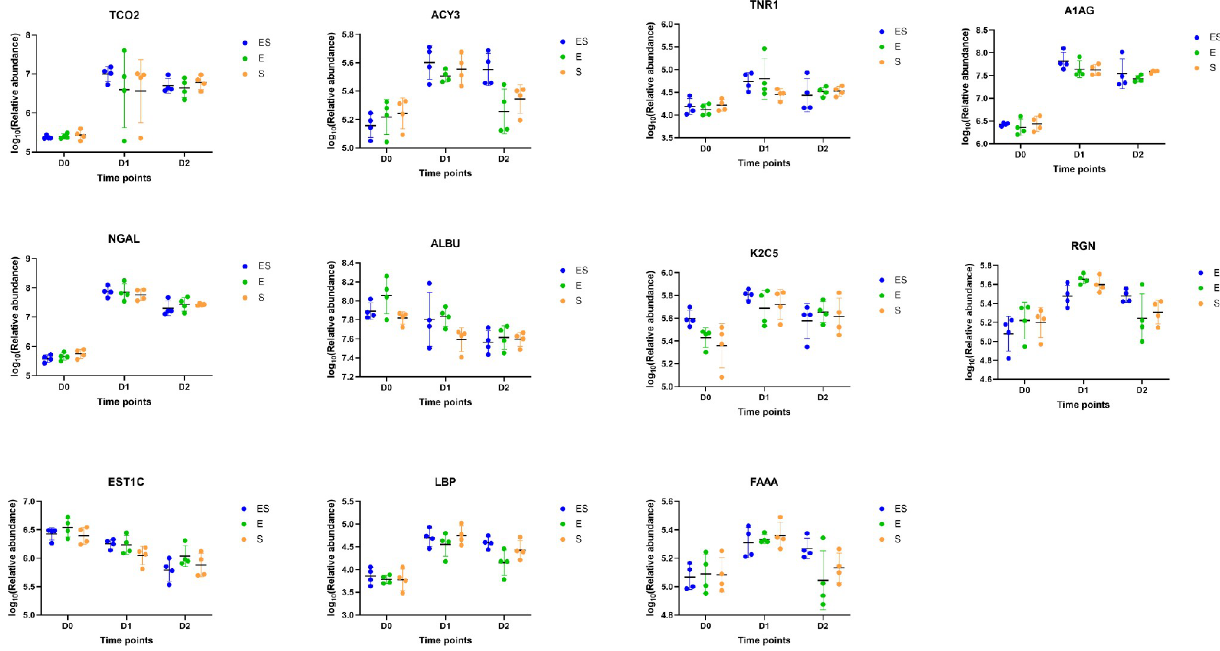
Fig 4. Expression of 11 differential proteins commonly identified in three